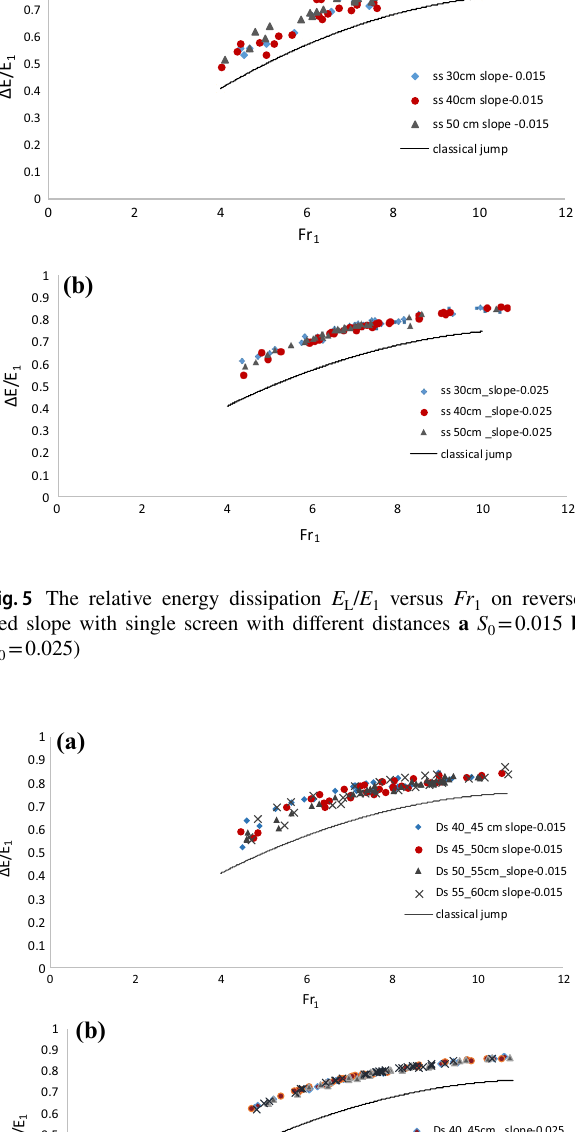
E Fr L / 1 versus 1 on reverse